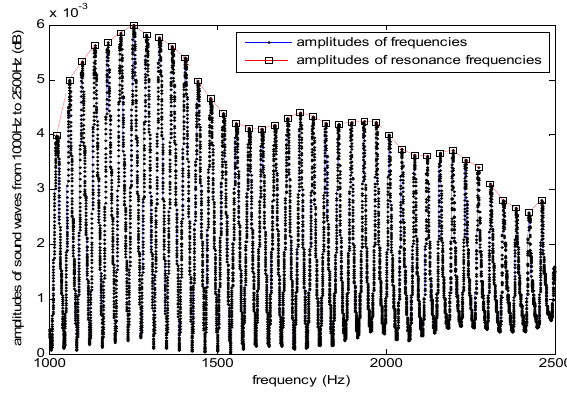
Figure 7. Resonance frequencies and amplitudes ( L = 4.6 m).